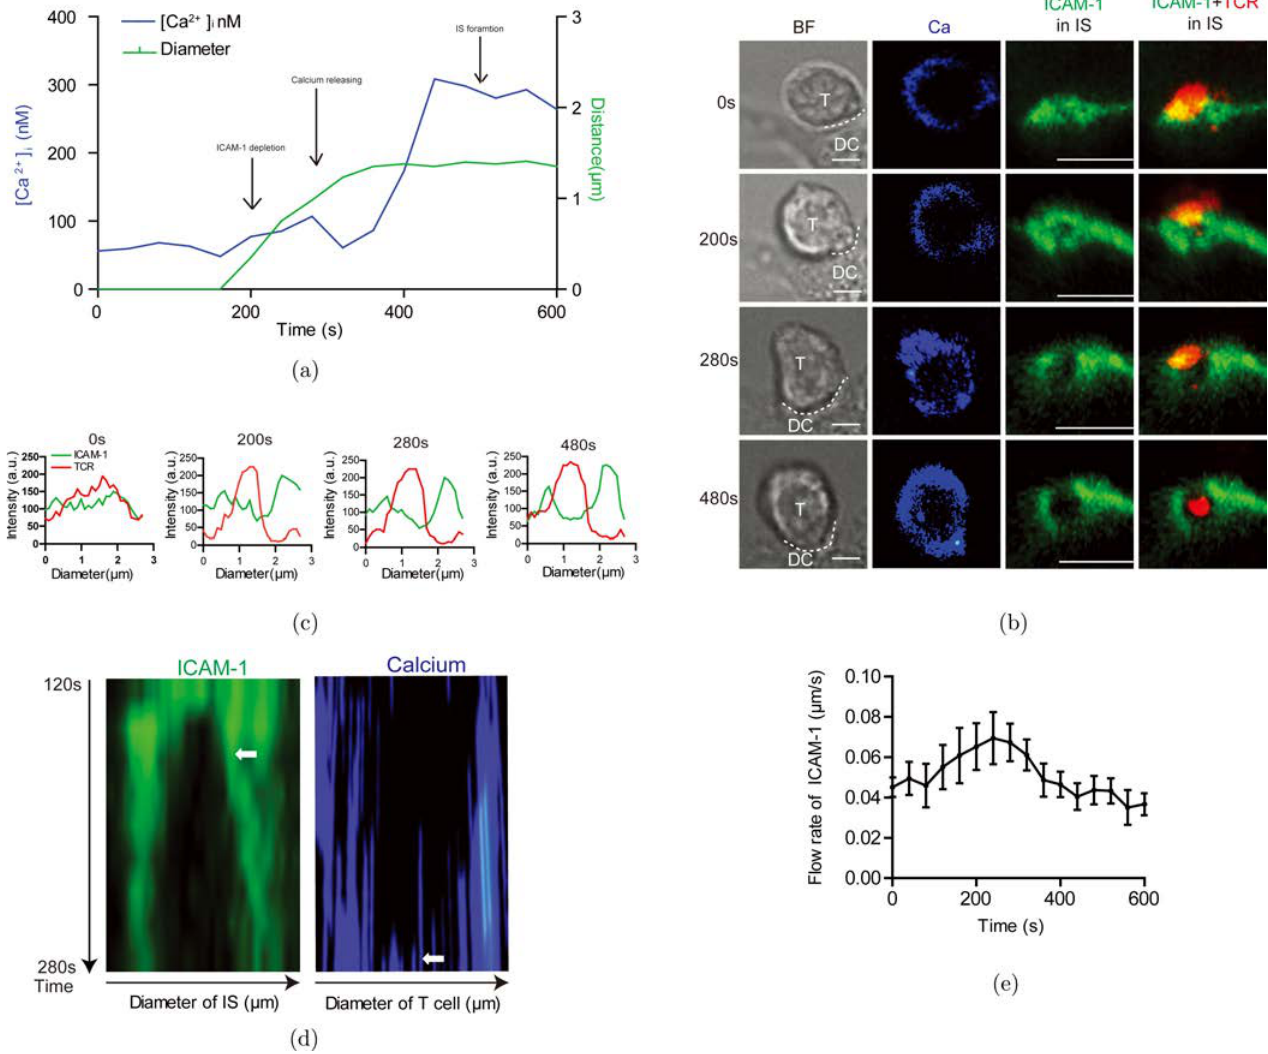
Fig. 1. ICAM-1 depletion in a bullseye IS occurred before calcium release in a T-cell: (a) The relationship between the diameter change of the area of ICAM-1 depletion and calcium signaling in a T-cell. (b) Images of calcium signaling in a T-cell and synapse formation at di®erent time points. Bar ¼ 2 (cid:2) m. (c) Analysis of °uorescent distribution of ICAM-1 and TCR along the diameter of the synapse at di®erent time points. (d) Kymograph analysis of the relationship between ICAM-1 depletion from the center to the periphery and calcium release in a T-cell. The white arrow in the left panel indicates the trend of ICAM-1 movement from the center to the periphery of the IS. The white arrow in the right panel indicates the calcium release in a T-cell. (e) The °ow rates of ICAM-1 in the synapse during bullseye IS